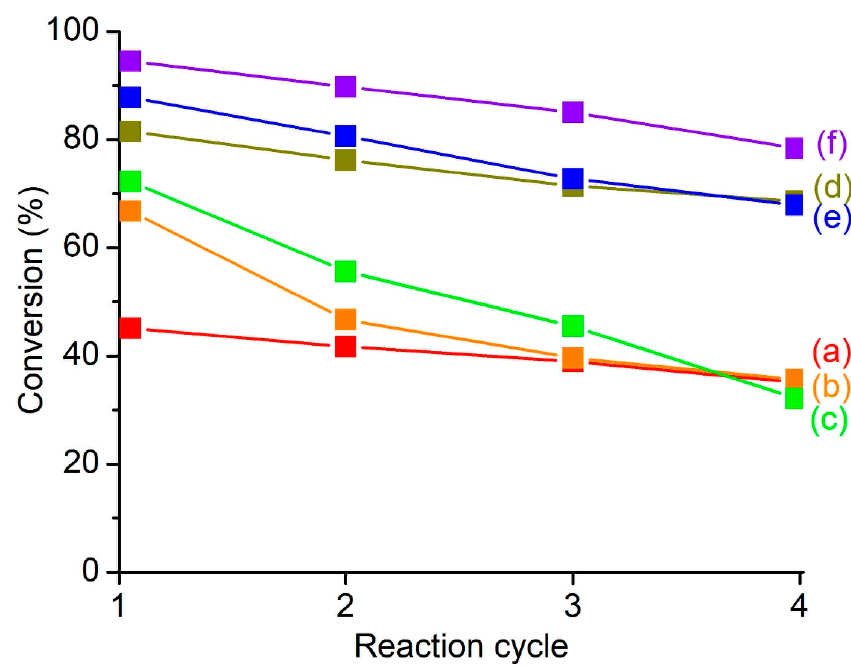
Figure 7. Reusability test of ( a ) SAPO-5, ( b ) CuCl x /SAPO-5, ( c ) CoCl x /SAPO-5, ( d ) SnCl x /SAPO-5, ( e ) FeCl x /SAPO-5 and ( f ) ZnCl x /SAPO-5 for consecutive five reaction cycles. Reaction conditions: temperature = 110 °C, time = 20 min, 2-methylfuran = 4.7 mmol, acetic anhydride = 14.1 mmol, catalyst = 0.20 g MCl x /SAPO-5.